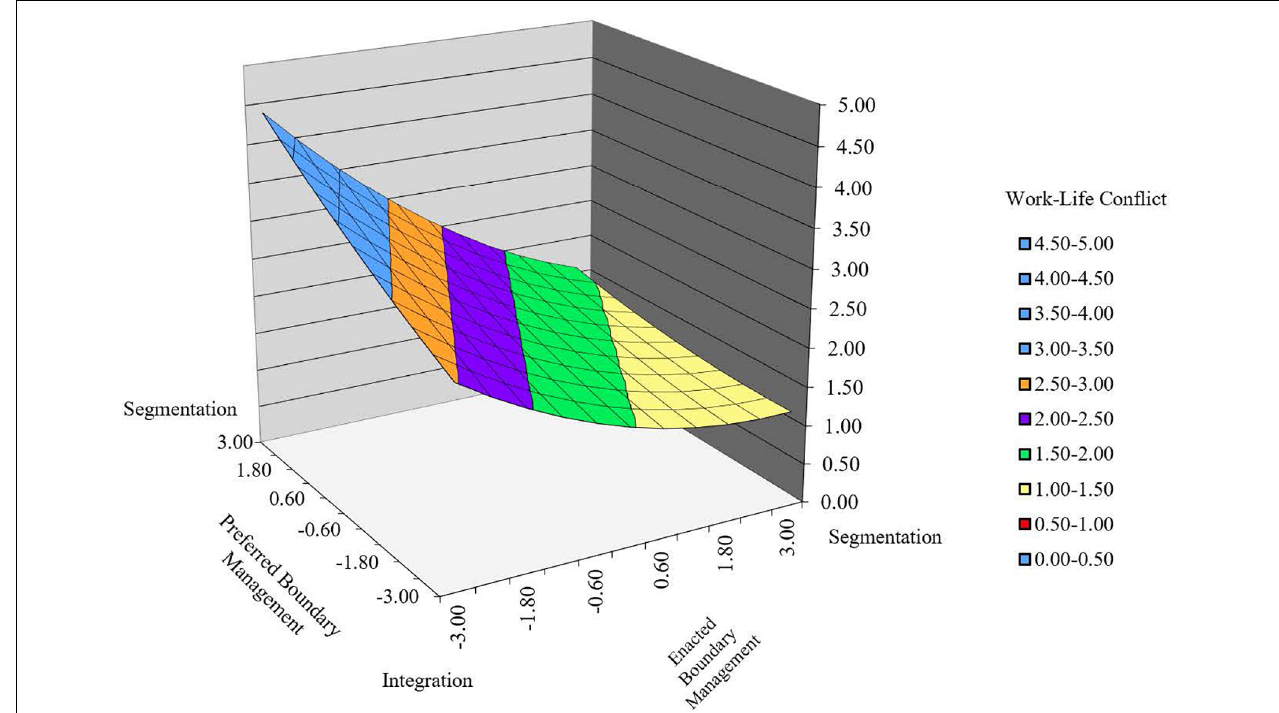
FIGURE 2 | Response surface with associated lines of congruence and incongruence of the polynomial regressions for enacted boundary-management and preferred-management explaining work-life conflict.